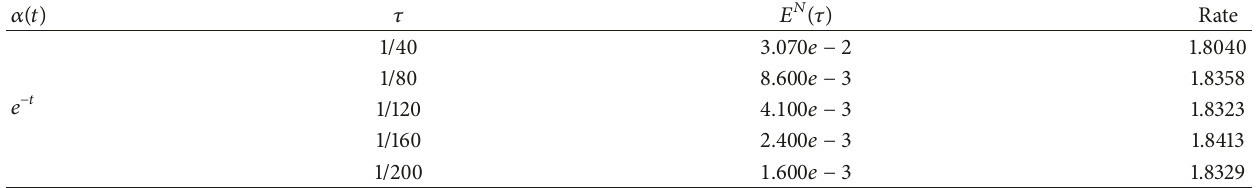
Table 5: Maximum errors and convergence rates for Example 1 at 𝑇 = 2 and 𝜎 3 = 𝜎 + 0.1 .